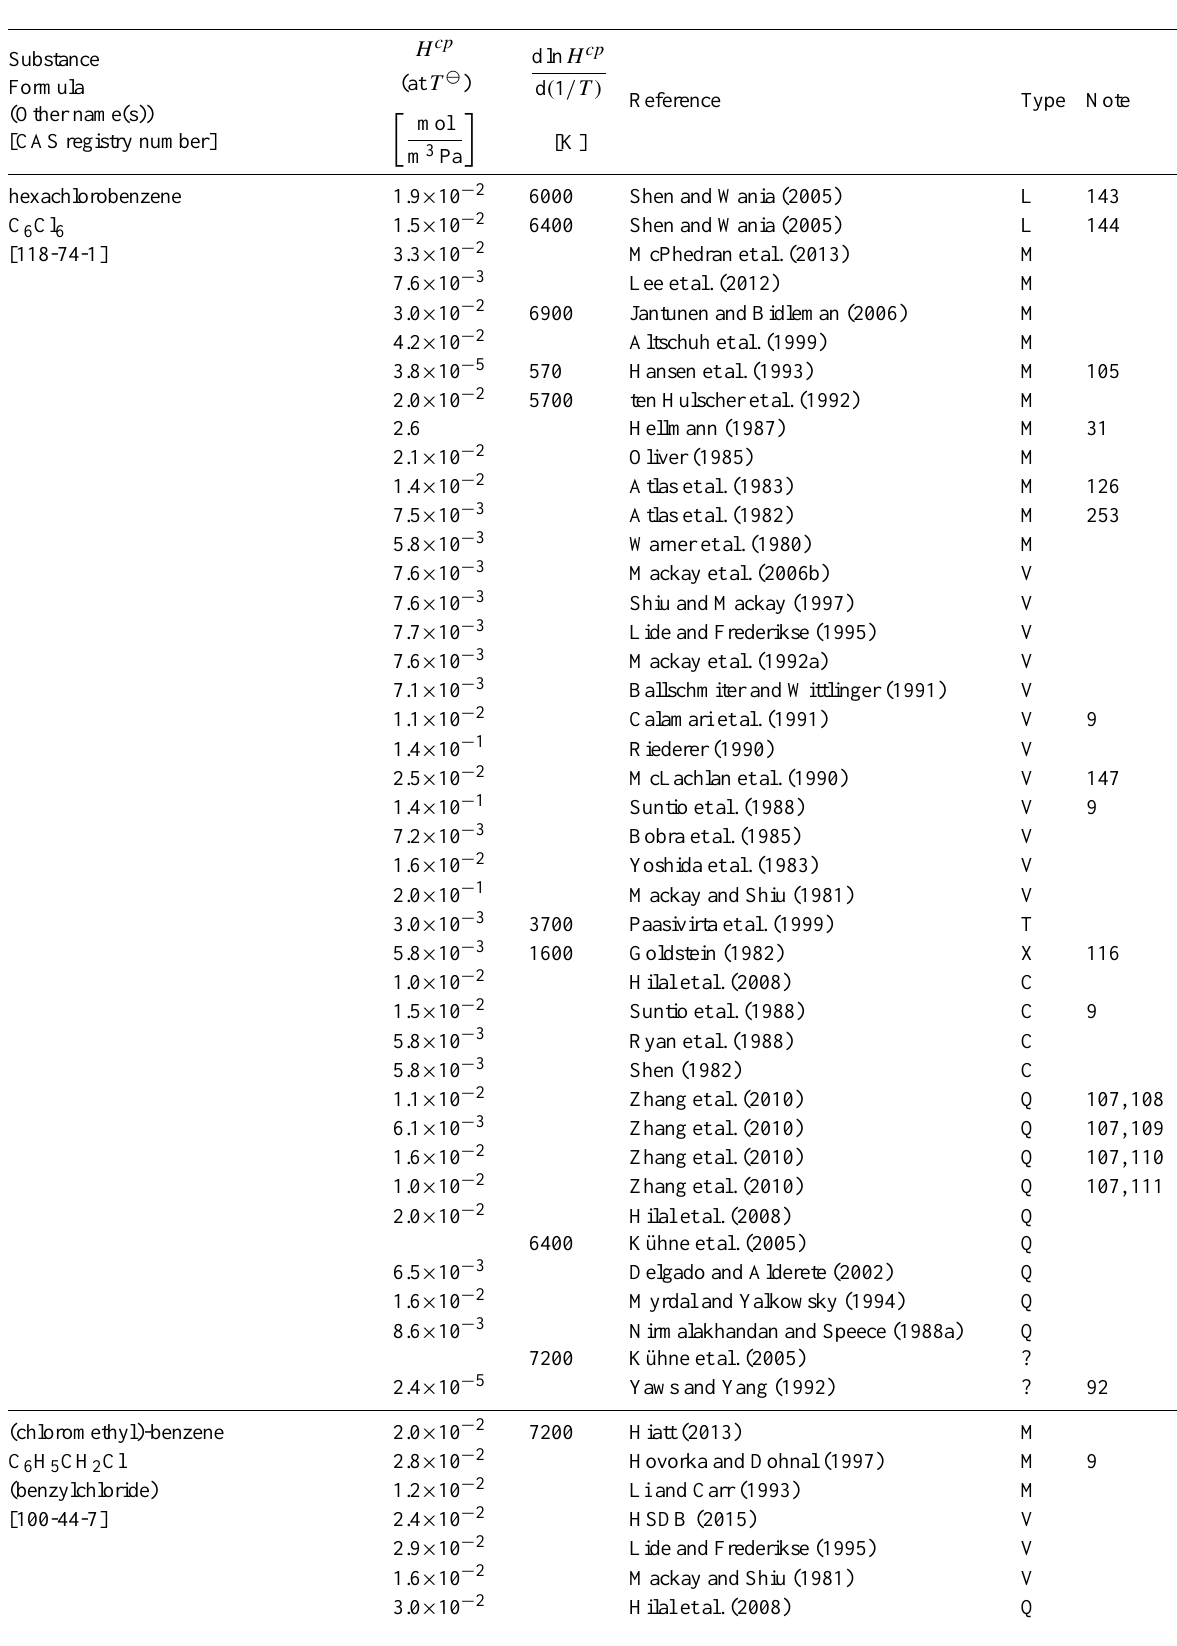
Table 6: Henry’s law constants for water as solvent